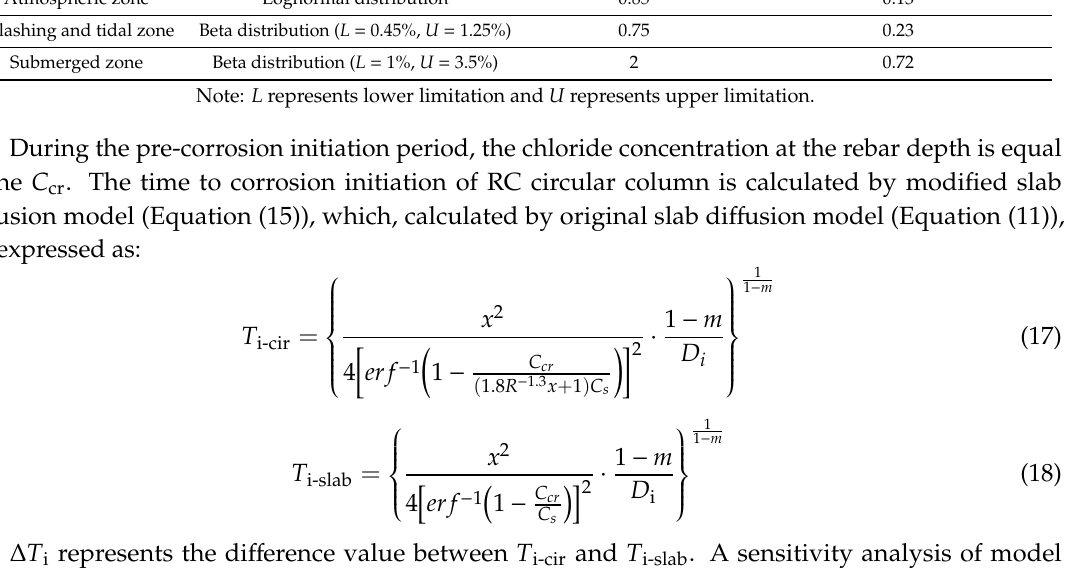
Table 3. The probability distribution of chloride threshold concentration C cr .